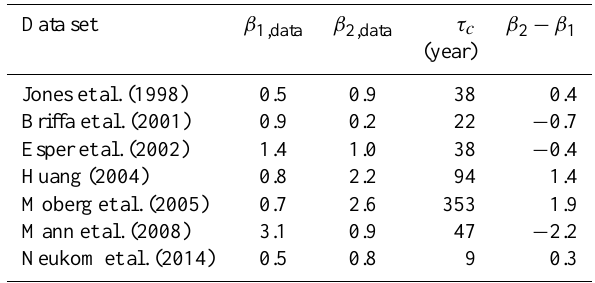
Table 2. Results using approach 2 for multiproxy temperature re- constructions.